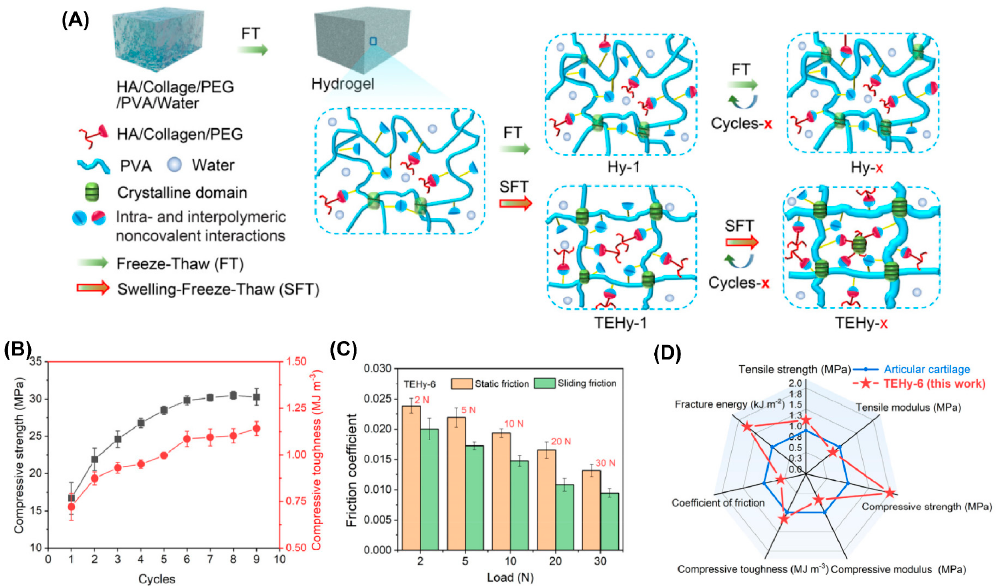
Figure 8. ( A ) Schematic illustration of the fabrication procedures of TEHy-x via the swelling-freeze– thaw method. ( B ) Compressive toughness and compressive strength of TEHy-x under different numbers of FTS cycles. ( C ) Static and sliding friction coefficients of TEHy-6 under different loads. ( D ) Summary and comparison of seven properties of the TEHy-x and AC in a radar chart. Reprinted with permission from Ref [82]. Copyright 2022, American Chemical Society.